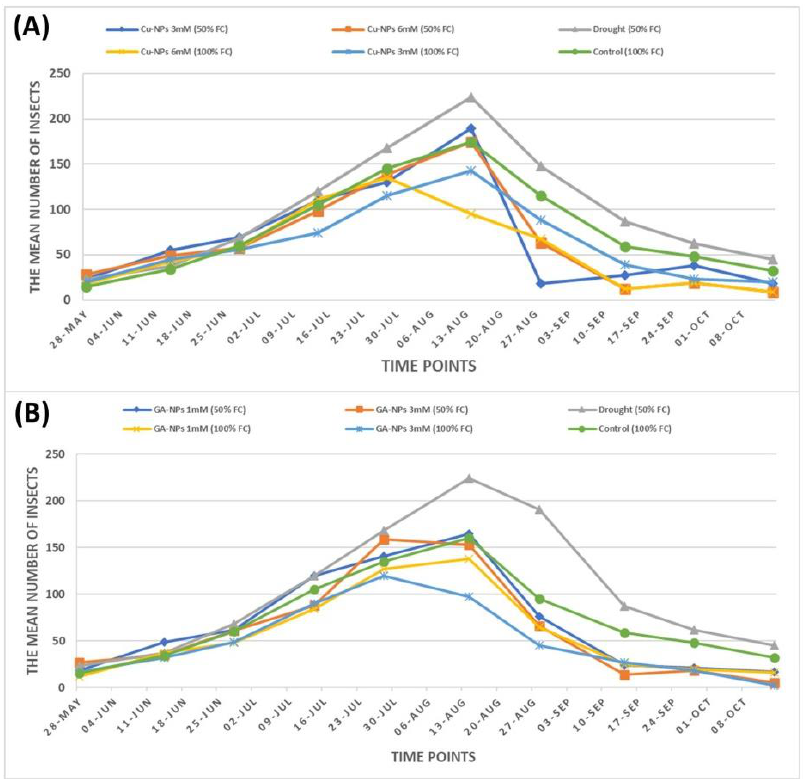
Figure 6. ( A ). Mean of seasonal abundance of mites infesting soybean plants under treatments by Cu-NPs at 3 and 6 mM, ( B ). Mean of seasonal abundance of mites infesting soybean plants under treatments by GA-NPs at 1 and 3 mM under normal irrigation (100% FC) and drought stress (50% FC), during the successive growing seasons of 2020 –